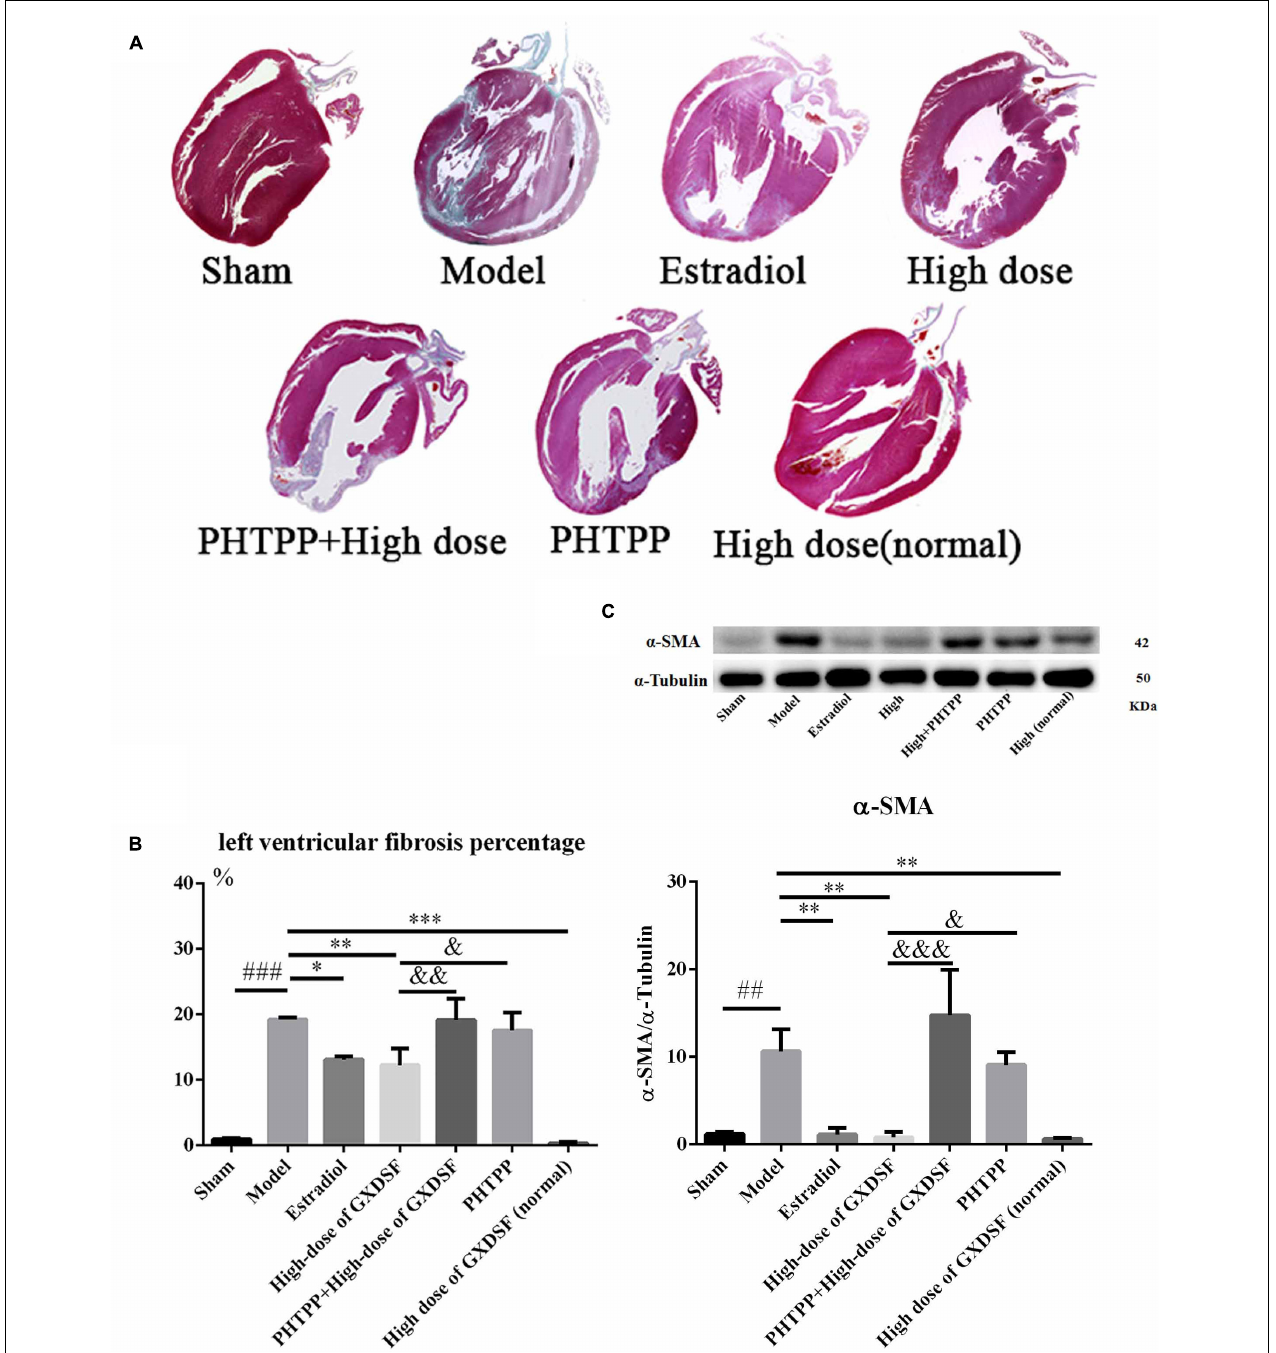
FIGURE 7 | Myocardial fibrosis in MIRI-LVR rats treated with high-dose of GXDSF treated group and PHTPP. Masson’s trichrome staining (A) and the percentage of left ventricular fibrosis area (B) are shown. A gel image with an internal reference ( α –tubulin) and the relative expression of α –SMA ( C ; column graph) are shown. Compared with the sham group: ## P < 0.01, ### P < 0.001. Compared with the MIRI-LVR model group: ∗ P < 0.05, ∗∗ P < 0.01, ∗∗∗ P < 0.001. Compared with the high-dose of GXDSF treated group: & P < 0.05, && P < 0.01, &&& P < 0.001. The data are presented as the mean ± SD ( n = 4 in each group).